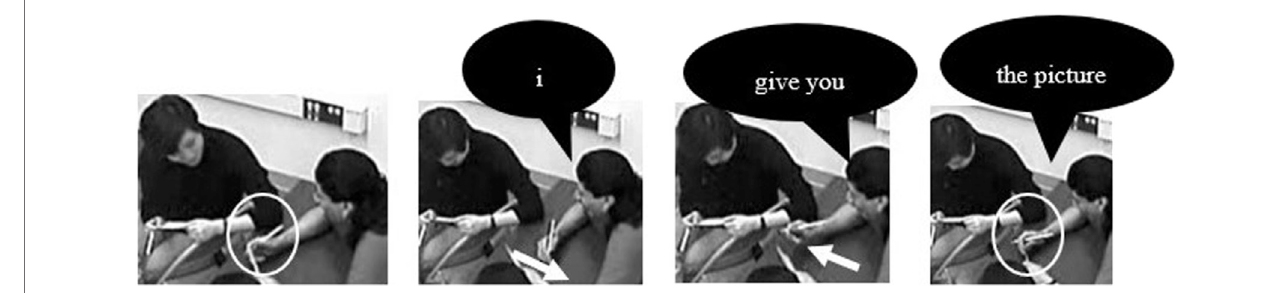
FIGURE 14 | Extract 6: i give you the picture.